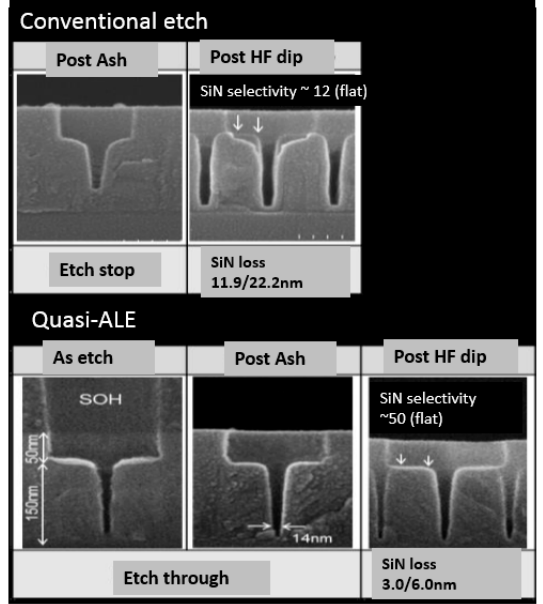
Figure 16. Cross-section SEM images of self-aligned contact (SAC) structure after the conventional etch and optimized Quasi-ALE. Reproduced with permission from [128]. Copyright IEEE, 2016.